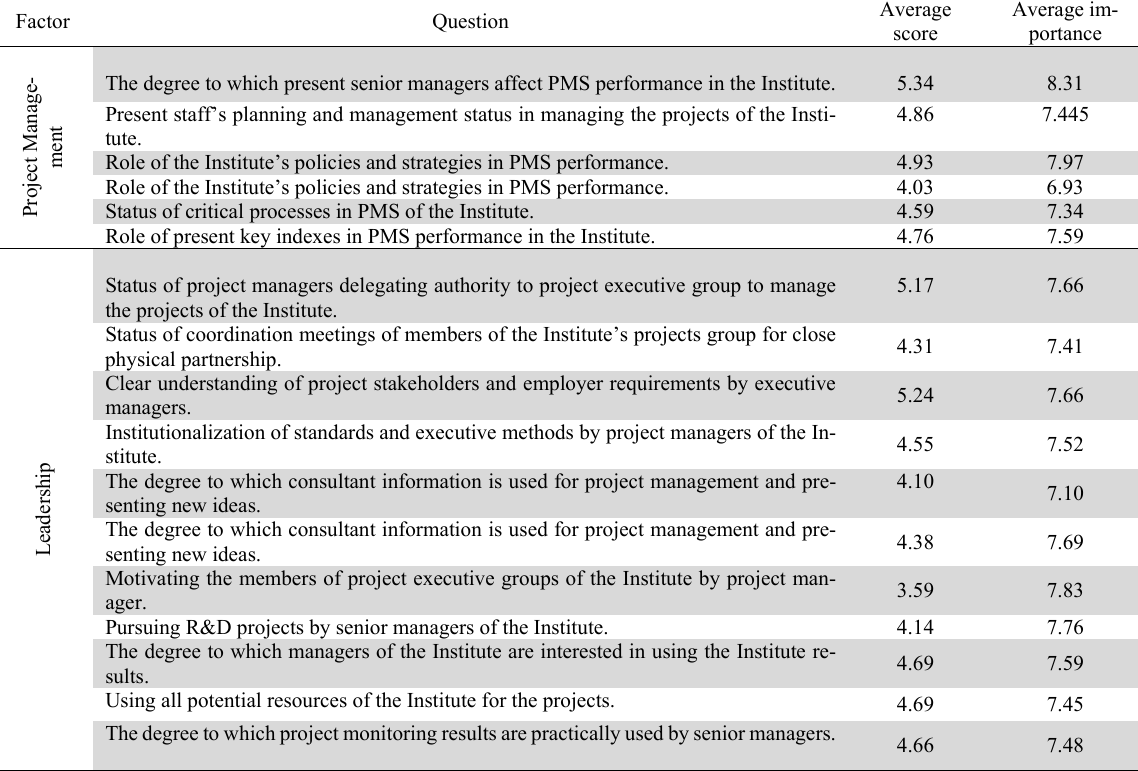
The results obtained for all CRs based on the questionnaire Factor Question